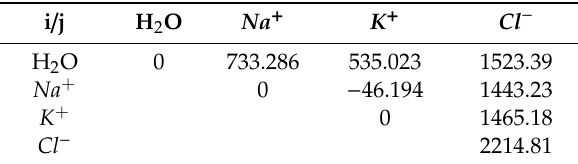
of UNIQUAC model [16,23]. ji